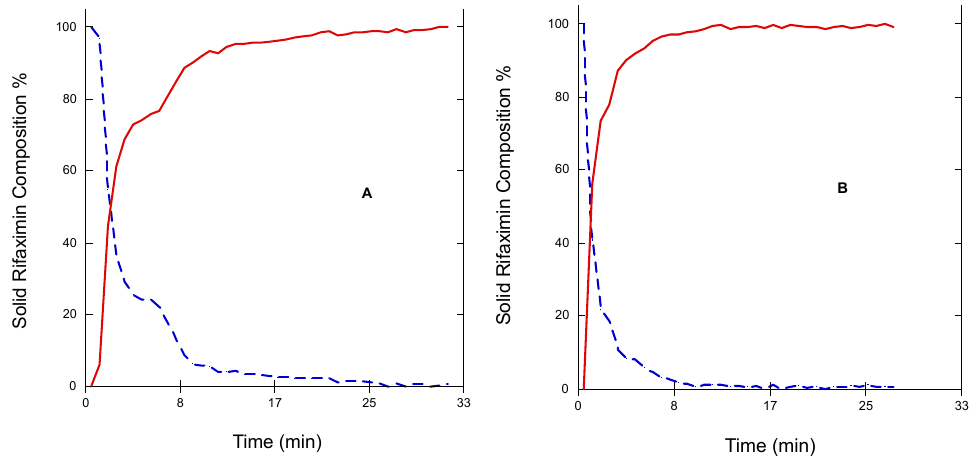
Figure 7. Trend upon chemometric analysis of the 3D IR spectrum of rifaximin α form exposed to environmental humidity ( A ) and 95% RH ( B ). Rifaximin α form (dashed line) β form (solid line).